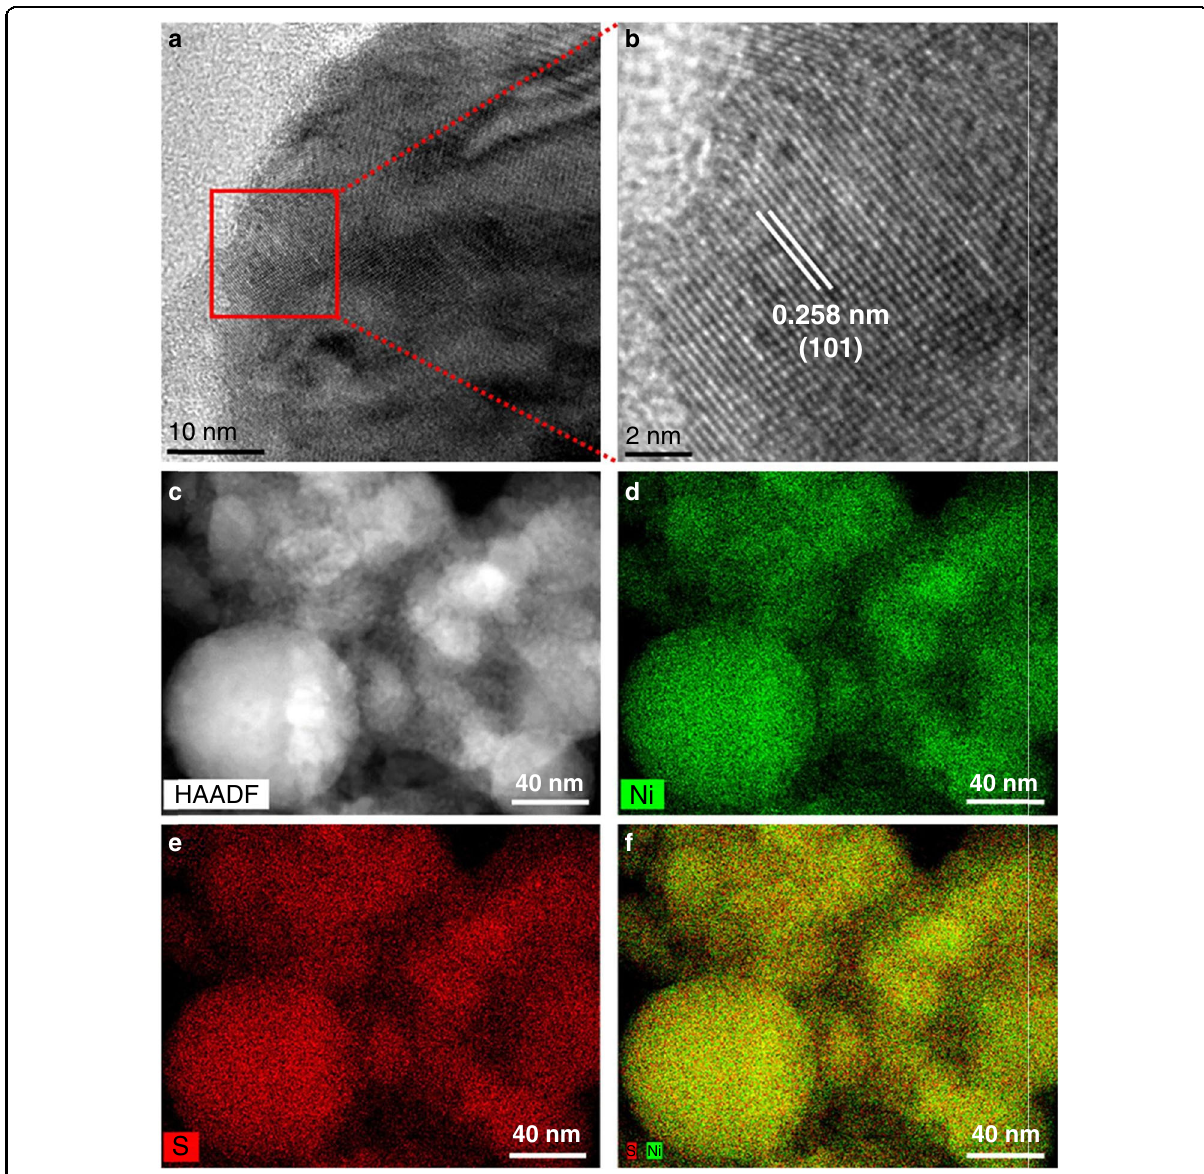
Fig. 14 Surface structures of NiS by PLI process. a , b HR-TEM lattice fringes of NiS-4 h, c their corresponding HAADF image, d , e elemental mapping of Ni, S through STEM analysis, and f overall distribution of Ni and S elements 165 . Copyright (2021)